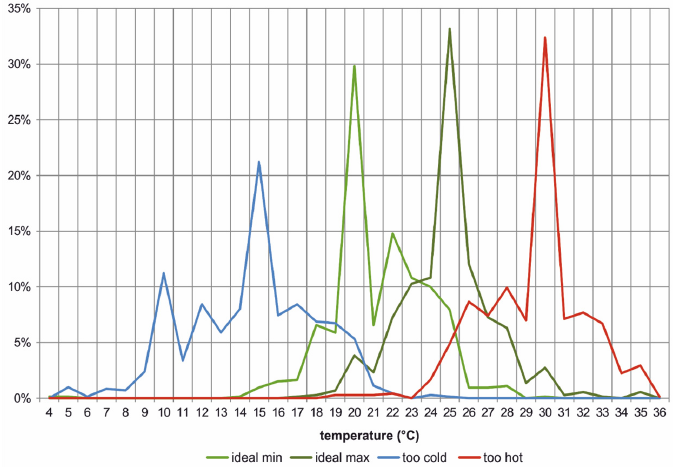
Figure 4. Distribution of answers for ideal and unacceptable temperatures.